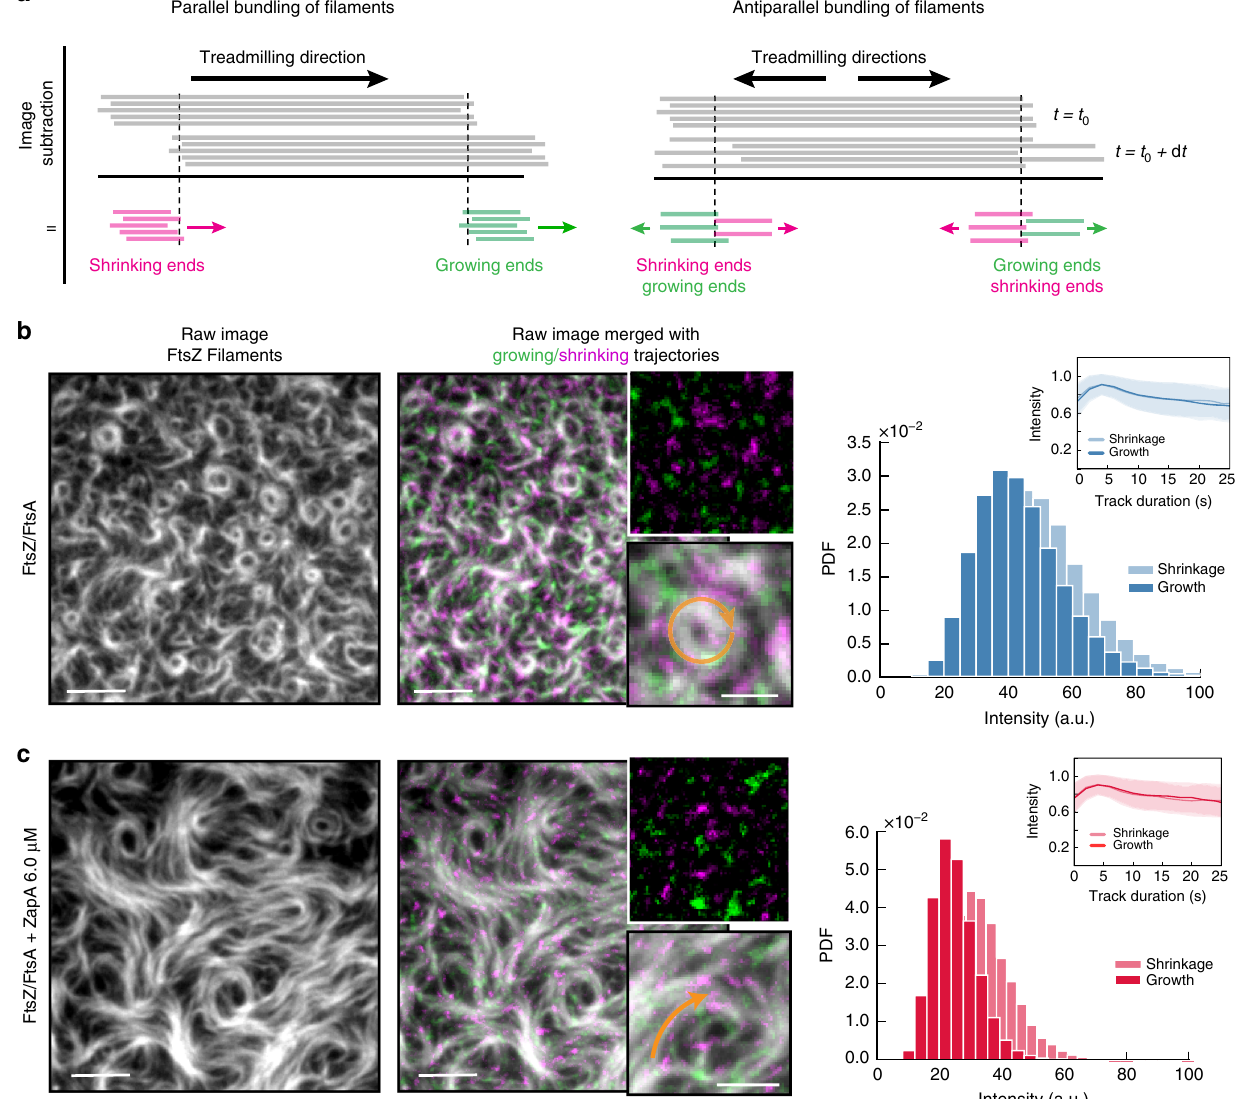
Fig. 4 ZapA does not change orientation of FtsZ fi laments. a Illustration of image subtraction step assuming parallel (left panel) or antiparallel fi lament bundles (right panel). For parallel bundles of treadmilling fi laments, image subtraction results in fl uorescent spots corresponding to FtsZ binding or detaching from a fi lament bundle allowing to visualize polymerization (growth, green) and depolymerization (shrinkage, magenta) trajectories. We expect that spots corresponding to growing and shrinking ends have similar intensities and closely follow each other. In contrast, for antiparallel bundles of treadmilling fi laments, the spots corresponding to growth and shrinkage would move in opposite directions and cross each other. b Raw image of FtsZ fi lament network and the corresponding differential image overlaid showing growing (green) and shrinking (magenta) ends without ZapA and ( c ) in the presence of 6.0 μ M ZapA. Orange arrows indicate treadmilling direction. Right: Intensity distribution of fl uorescence spots generated from a differential time-lapse movie of FtsZ/FtsA fi laments and with 6.0 μ M ZapA ( c ). Insets depict the mean normalized intensities and standard deviation (shaded error bands) of spots versus trajectory length. The presence of ZapA does not change fl uorescent spot intensity and accordingly fi lament orientation. Scale bars: large image, 5 μ m; small image, 2 μ m. Source data available at Figshare [https://doi.org/10.6084/m9. fi